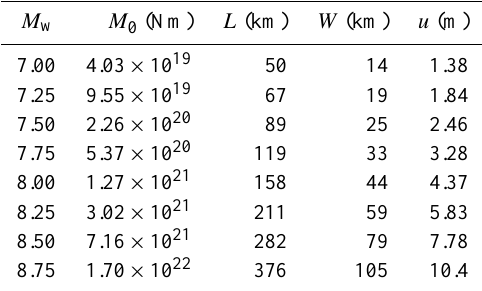
Table 3. Main parameters for the WLU-2 model of large earthquake generation in the Gulf of Cadiz-SW Iberia region. This model ap- plies only to zone GC09.